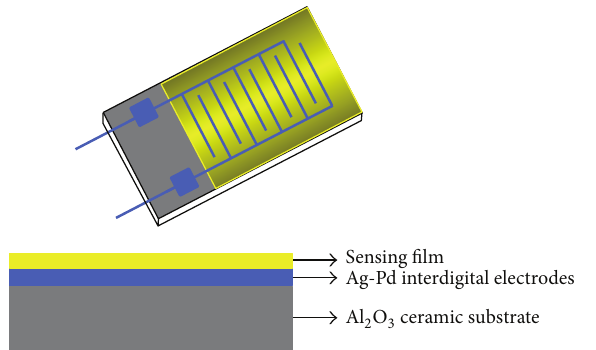
Figure 1: The electrode configuration structure of the humidity